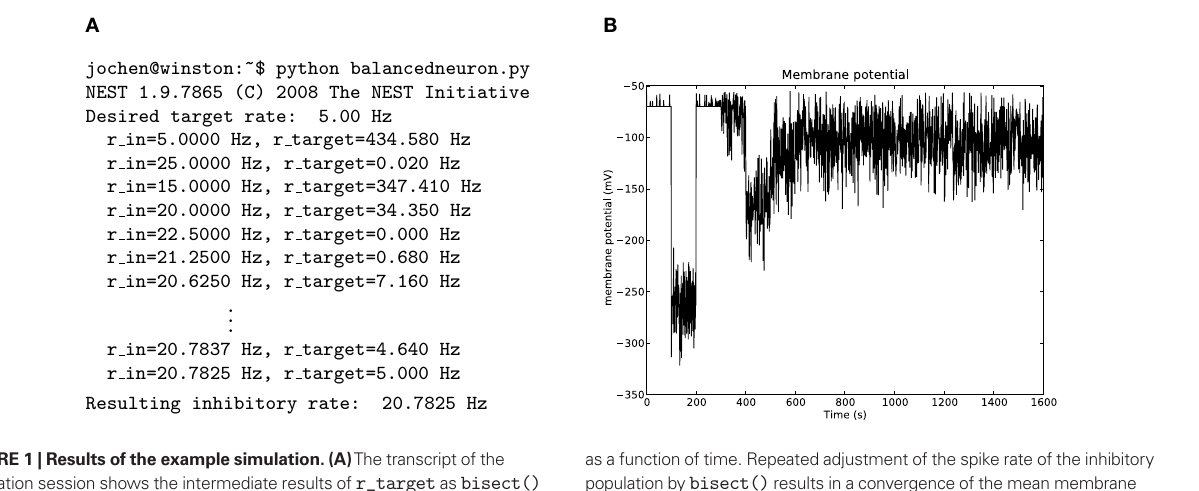
FIGURE 1 | Results of the example simulation. (A) The transcript of the simulation session shows the intermediate results of r_target as bisect() searches for the optimal rate. (B) The membrane potential of the target neuron